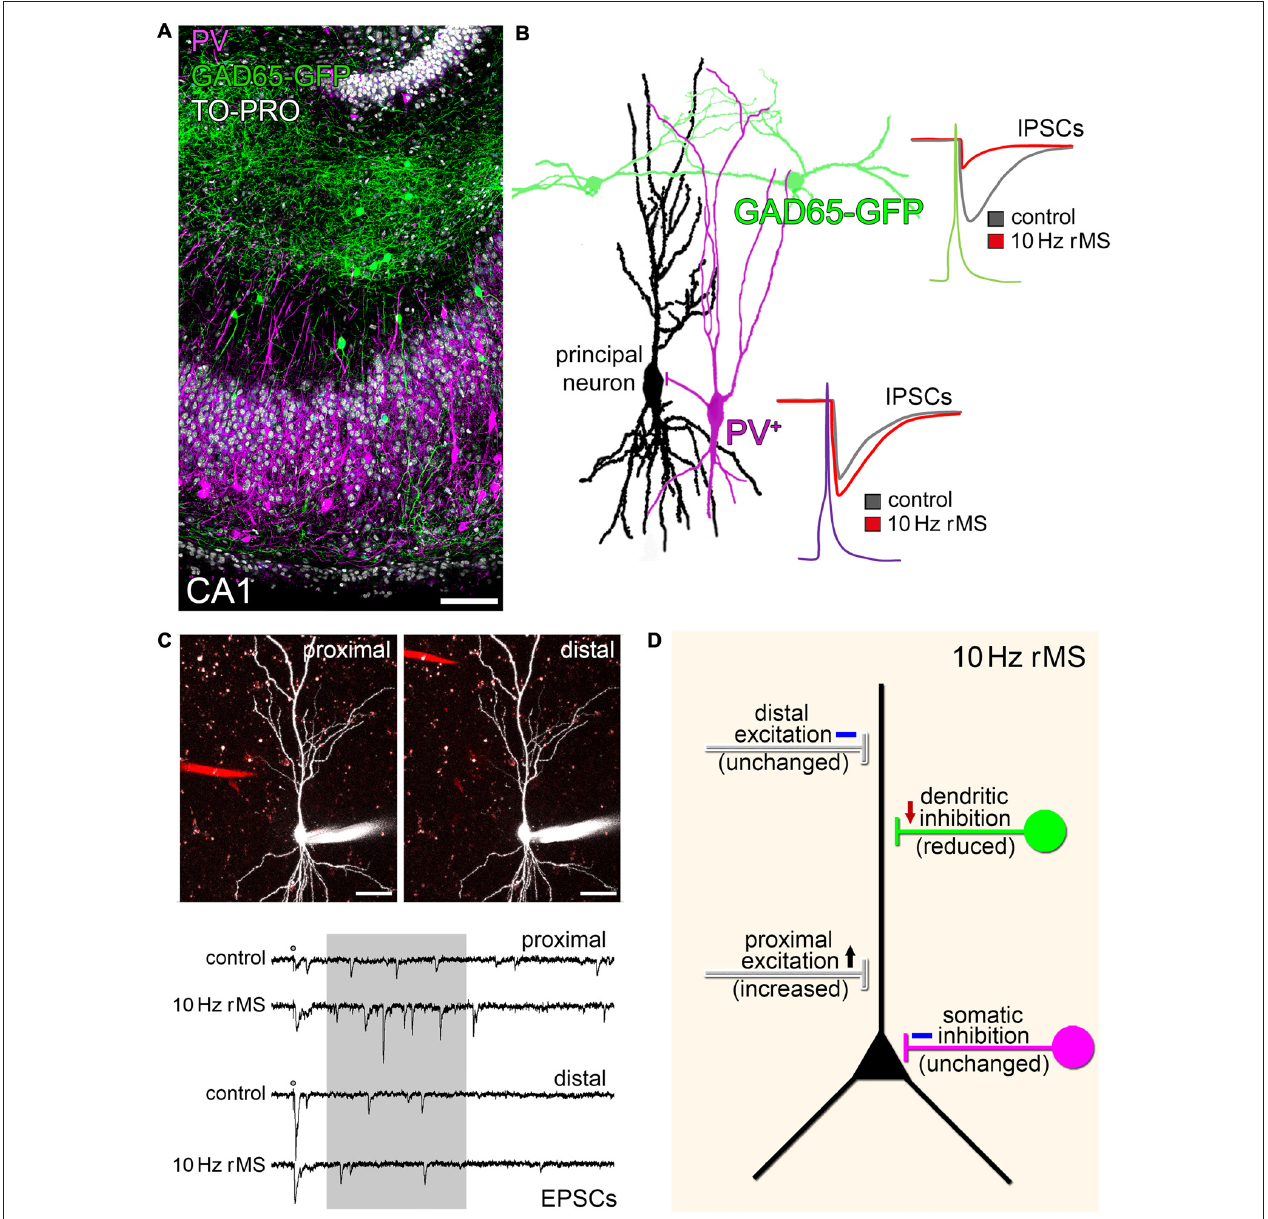
FIGURE 2 | rMS modulates network connectivity through changes of specific inputs on principal neurons. (A) CA1 region in an organotypic slice culture prepared from glutamate decarboxylase (GAD65)-GFP mice stained for parvalbumin (PV; nuclear stain, TO-PRO (cid:114) ; scale bar: 100 µ m). GFP identifies a population of interneurons that mainly project onto dendrites of CA1 pyramidal neurons, while PV-positive (PV + ) interneurons mediate somatic inhibition. (B) Paired recordings disclose that 10 Hz rMS reduces dendritic inhibition, while not affecting somatic inhibition (inhibitory postsynaptic currents, IPSCs; drawing based on original data; see Lenz et al., 2016). (C) The same 10 Hz stimulation protocol increases excitatory synaptic strength on proximal, but not distal dendritic segments. An example of local electrical stimulation (stimulating electrode; red) while recording from the same CA1 pyramidal neuron, and corresponding sample traces of excitatory postsynaptic currents are shown (asynchronous EPSCs analyzed in a time range of 100–500 ms after stimulation (shaded area); scale bars: 40 µ m; further experimental details provided in Lenz et al. (2015); copyright clearance obtained from Springer). (D) Schematic summarizing the major findings on input-specific effects of 10 Hz rMS in organotypic hippocampal slice cultures.